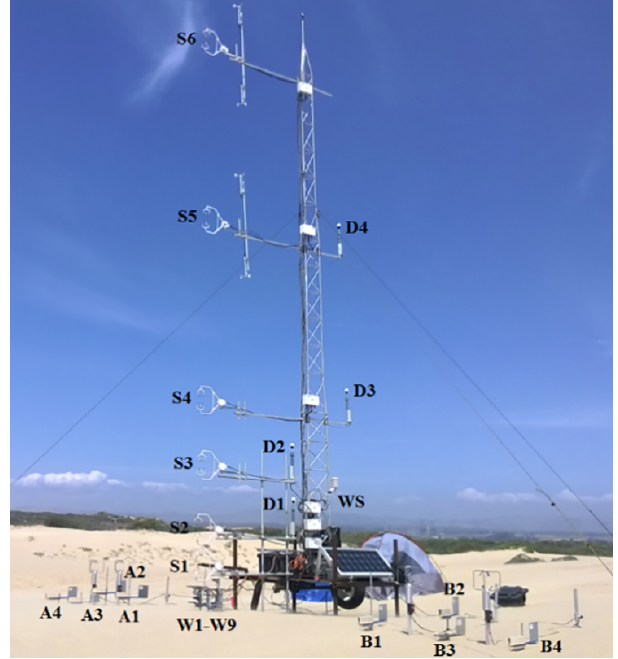
Figure 1. The experimental setup at Oceano Dunes. Instrumenta- tion includes six sonic anemometers (S1–S6), nine Wenglor parti- cle counters (W1–W9), eight Big Spring Number Eight sand sam- plers (A1–A4, B1–B4), four optical particle counters (D1–D4), and a weather station with temperature and humidity sensors (WS) (fol- lowing Martin and Kok,